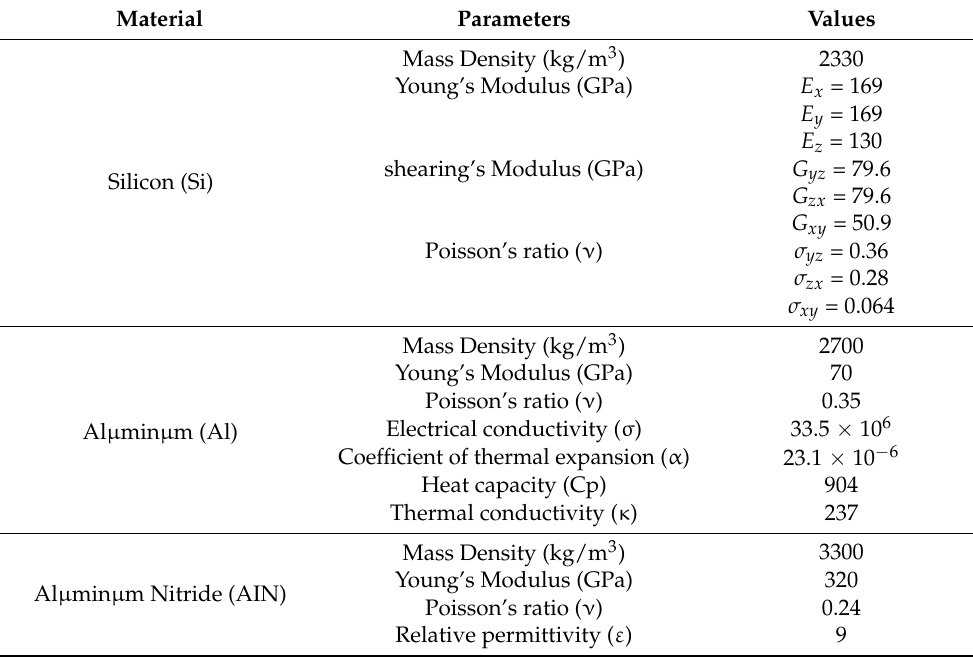
Table 1. The specific material parameters used in this